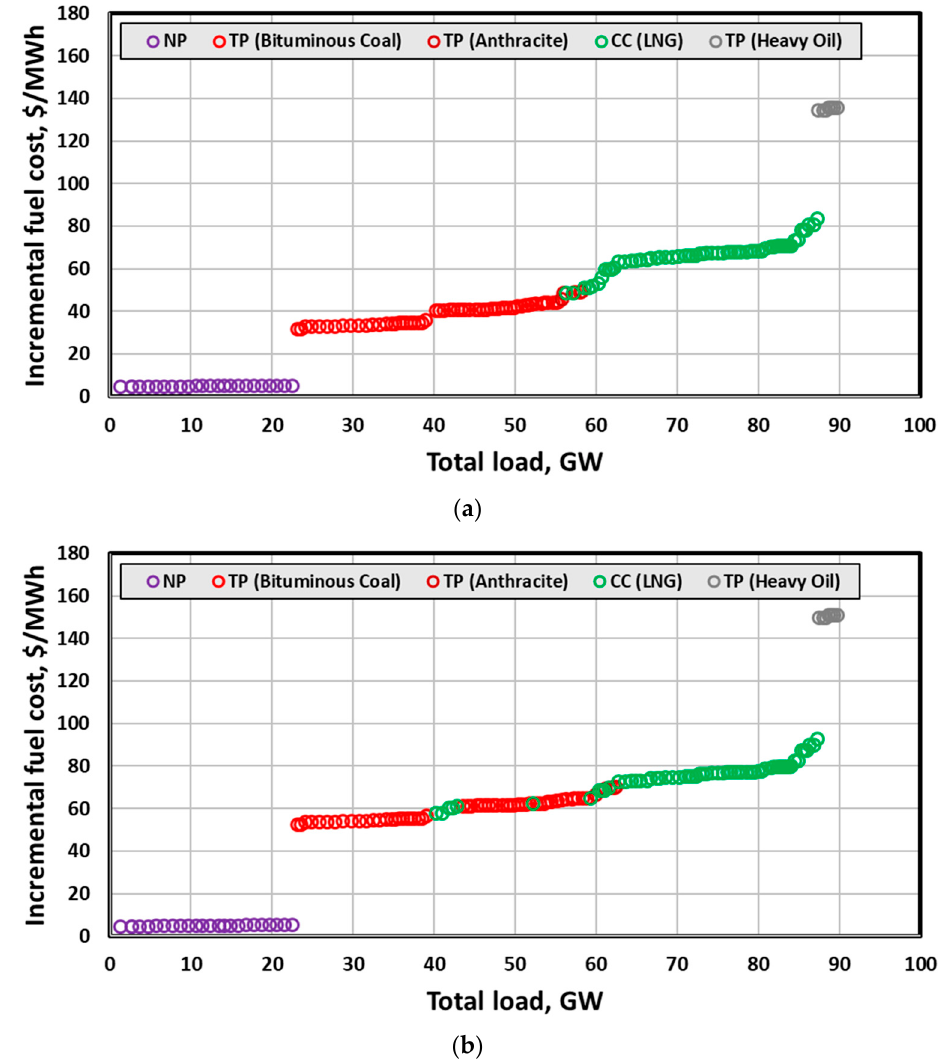
Figure 4. Optimum generator unit commitment curve by load; ( a ) Economic load dispatch (EcoLD); ( b ) Environmental load dispatch (EnvLD).